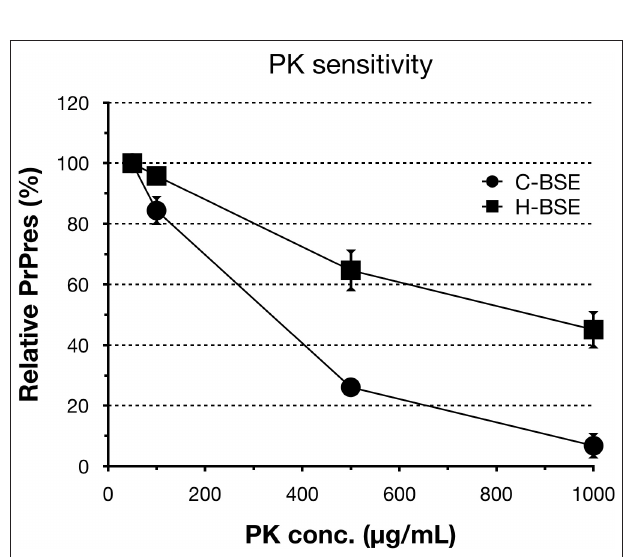
FIGURE 3 | PrP d sensitivity to different PK concentrations of hamster-adapted H-BSE. PK susceptibility was compared between H- and C-BSE strains in hamsters. The signal intensities were quantified by an image reader software (AlphaEaseFC; Alpha Innotech), whereby the intensity of 50 µ g/ml PK concentration was set as the reference point (100%). PrP res was detected with mAb 6H4. Symbols: black circles, C-BSE; black squares,